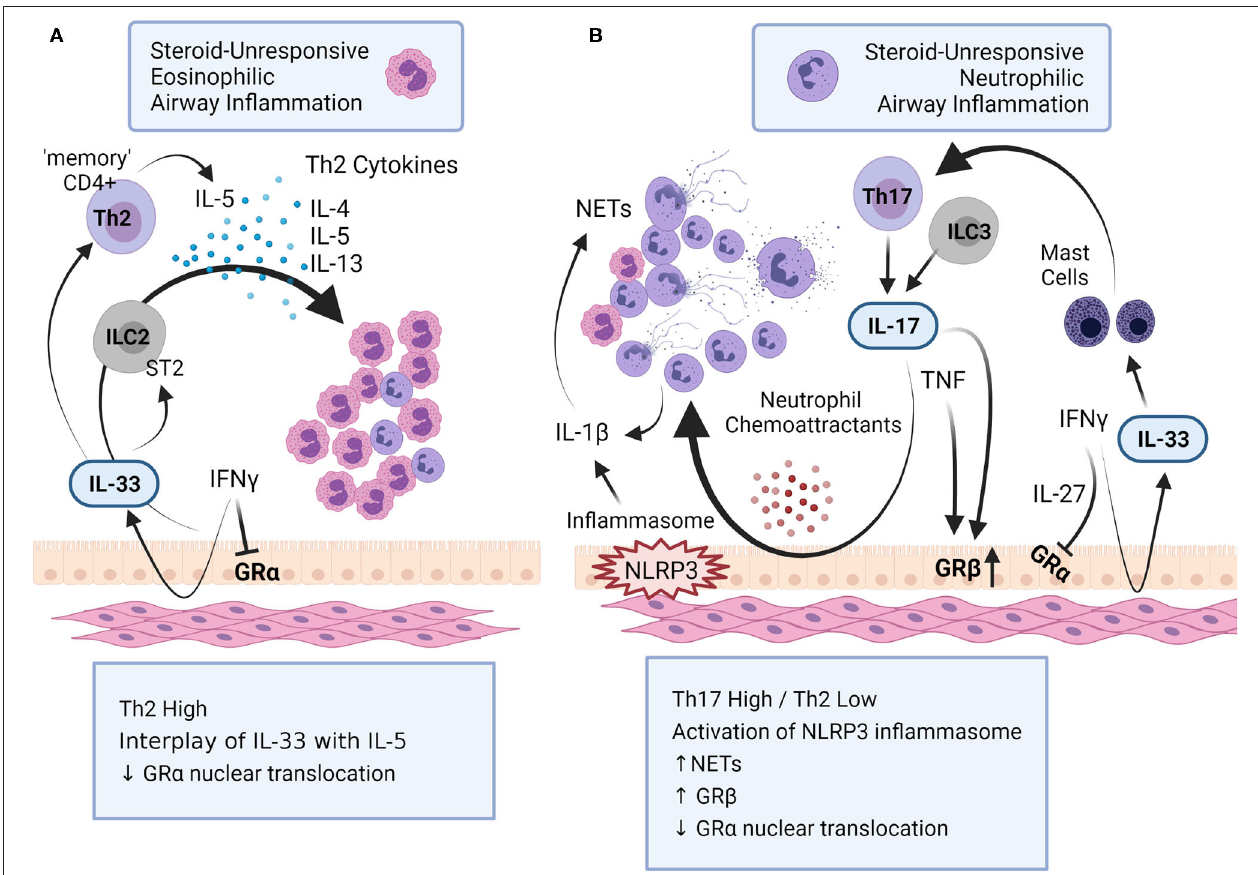
FIGURE 1 | Mechanisms of steroid-unresponsive airway inflammation. Steroid-unresponsive severe asthma (SA) includes both (A) eosinophilic and (B) neutrophilic airway inflammatory phenotypes. (A) Eosinophilic airway inflammation in SA is characterized by a Th2-high inflammatory phenotype with increased levels of Th2-cytokines such as IL-4, IL-5 and IL-13 that promote increased accumulation of eosinophils in the lungs. The alarmin IL-33 interacts with innate lymphoid cells (ILC) 2 to facilitate the production of Th-2 cytokines. In addition, chronic exposure to IL-33 results in “memory” CD4 + Th2 cells that preferentially produce IL-5. (B) Neutrophilic airway inflammation in SA is typically characterized with a Th17-high and Th2-low inflammatory phenotype, with increased accumulation of neutrophils in the lungs. Different cytokines, namely IL-17, IFN γ , TNF and IL-1 β , as well as the activation of inflammasome NLRP3, play a critical role in promoting neutrophilic airway inflammation in SA. Cytokines associated with both these immunophenotypes in SA dysregulates glucocorticoid receptor (GR) function; IFN γ and IL-27 suppress the nuclear translocation of GR α , the GR isoform that regulates glucocorticoid-mediated anti-inflammatory gene expression. IL-17 and TNF increases the expression of GR β , isoform that attenuates GR α . This figure summarizes some of the key mechanisms related to airway inflammation in SA (created with